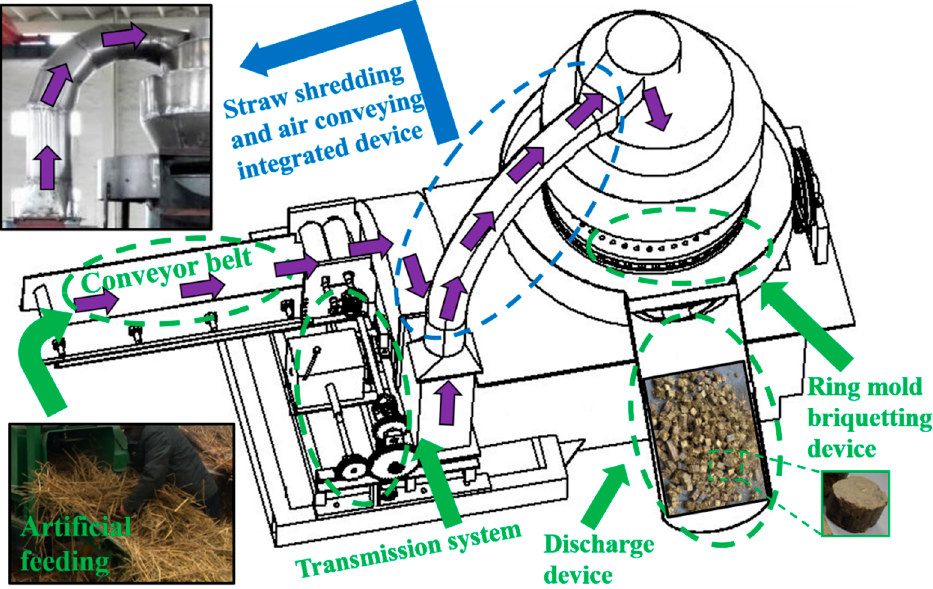
Figure 1. Schematic diagram of the structure of the movable straw briquetting machine.